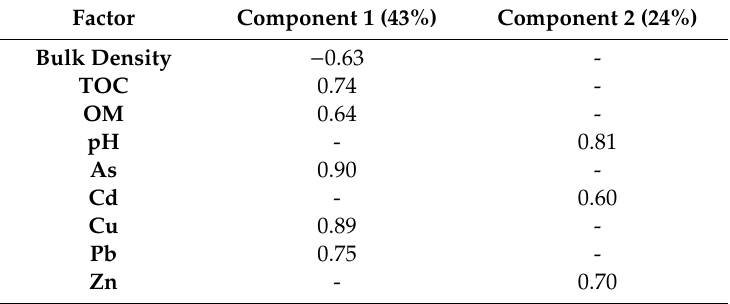
Table 1. Principal component analysis of the measured parameters from 52 urban soil samples. Data were standardized before analysis. The cumulative total explained 67% of the variance, with the remaining 33% attributable to external factors not measured in this study (factors with loadings higher than 0.6 were included in this analysis). Factor Component 1 (43%) Component 2 (24%) Bulk Density − 0.63 - TOC 0.74 - OM 0.64 - pH - 0.81 As 0.90 - Cd - 0.60 Cu Pb